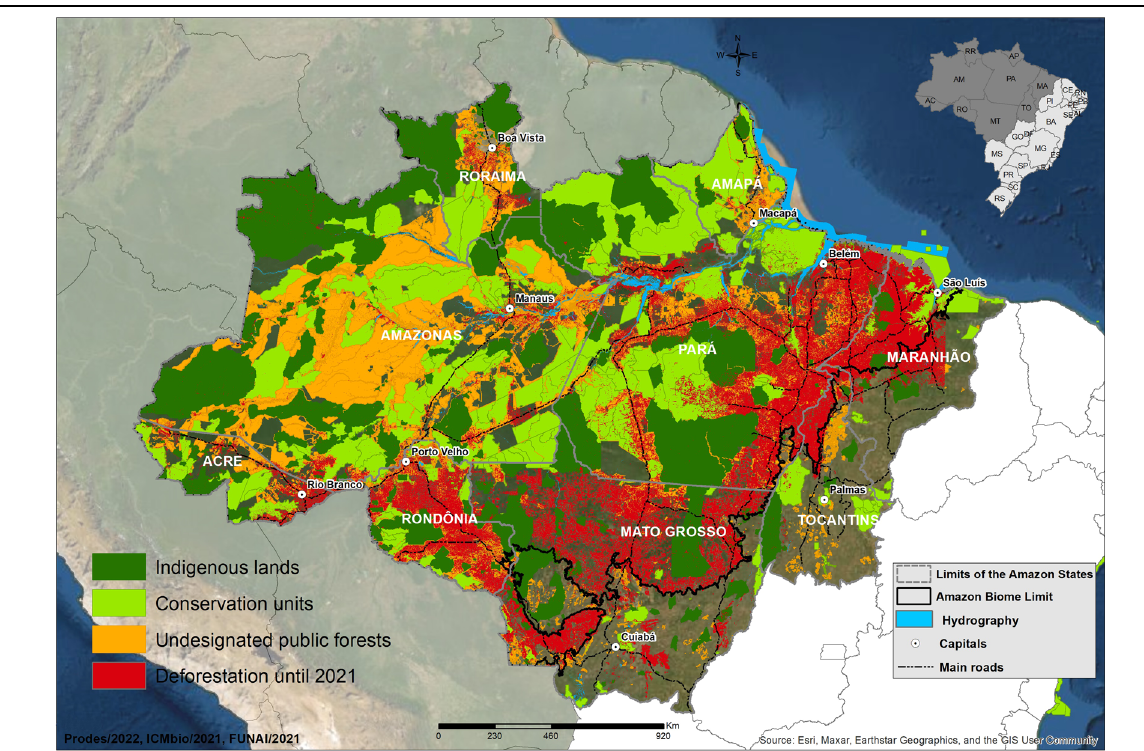
Fig. 1 | Protected areas, undesignated public forests, and the deforestation in the BrazilianAmazon. Undesignatedpublic forests (in orange),conservation units (in light green), indigenous lands (in dark green), and deforestation by 2021 (red dots). Source: refs. 2,21 – 23